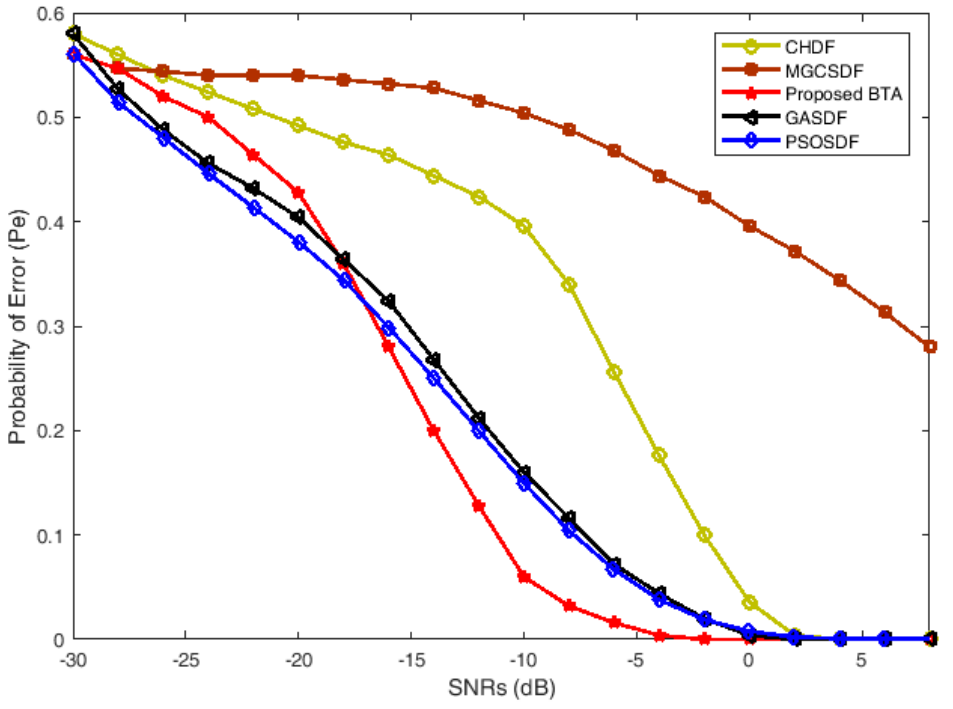
Figure 10. Probability of error vs. signal-to-noise ratio with the AY category of MUs.